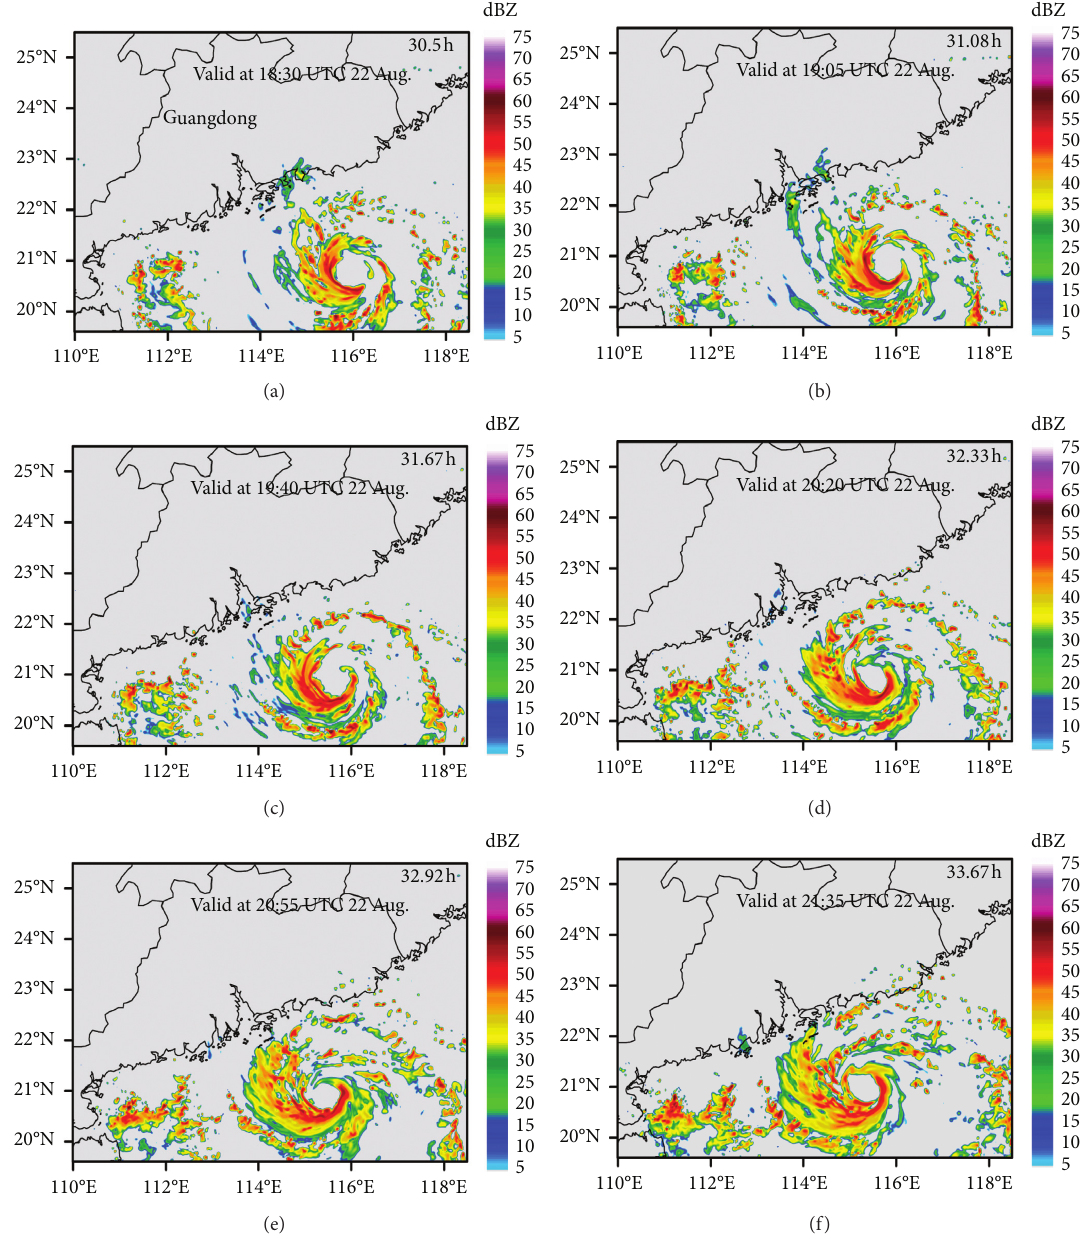
Figure 5: Reflectivity at 3km altitude (unit: dBZ) derived from the WRF simulation at model hours (a) 30.5, (b) 31.08, (c) 31.67, (d) 32.33, (e) 32.92, and (f)